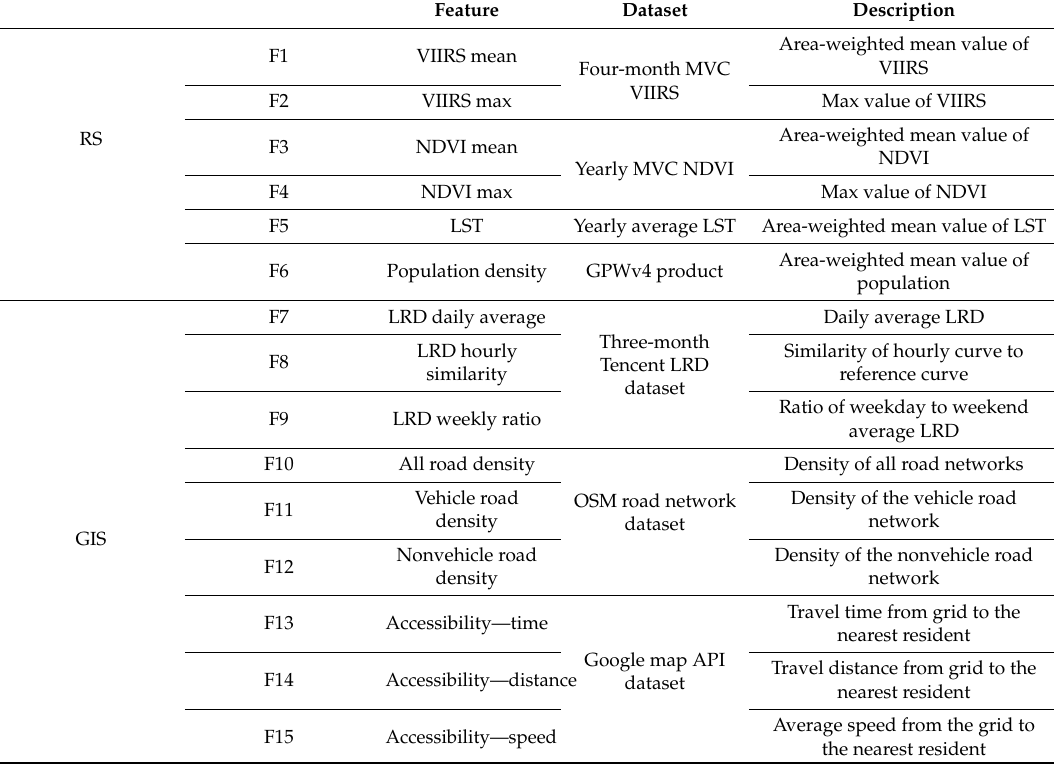
Table 2. The six RS and nine GIS potential features for the random forest classifier. All of the features were calculated based on a 0.01 degree grid.